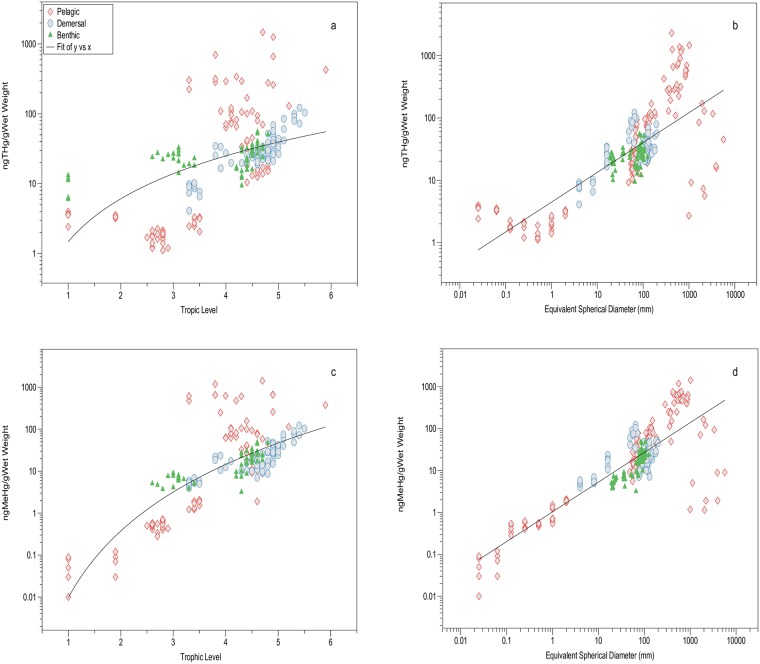
The relationship between ng THg/g wet weight and trophic level (a) and equivalent spherical diameter (b), and between ng MeHg/g wet weight and trophic level (c) and equivalent spherical diameter (d).